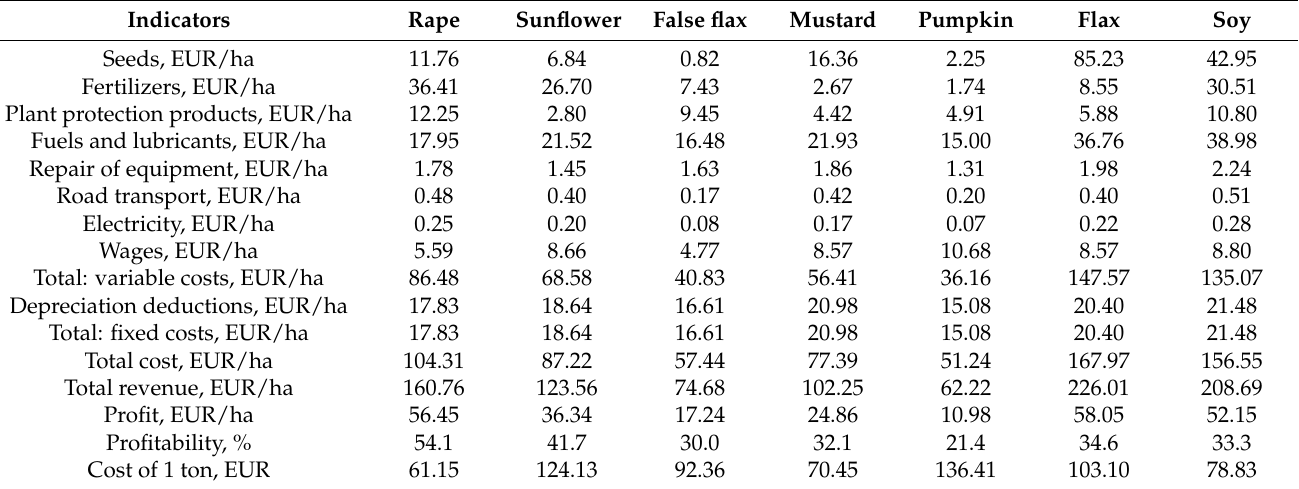
Table 11. Economic efficiency of oilseeds